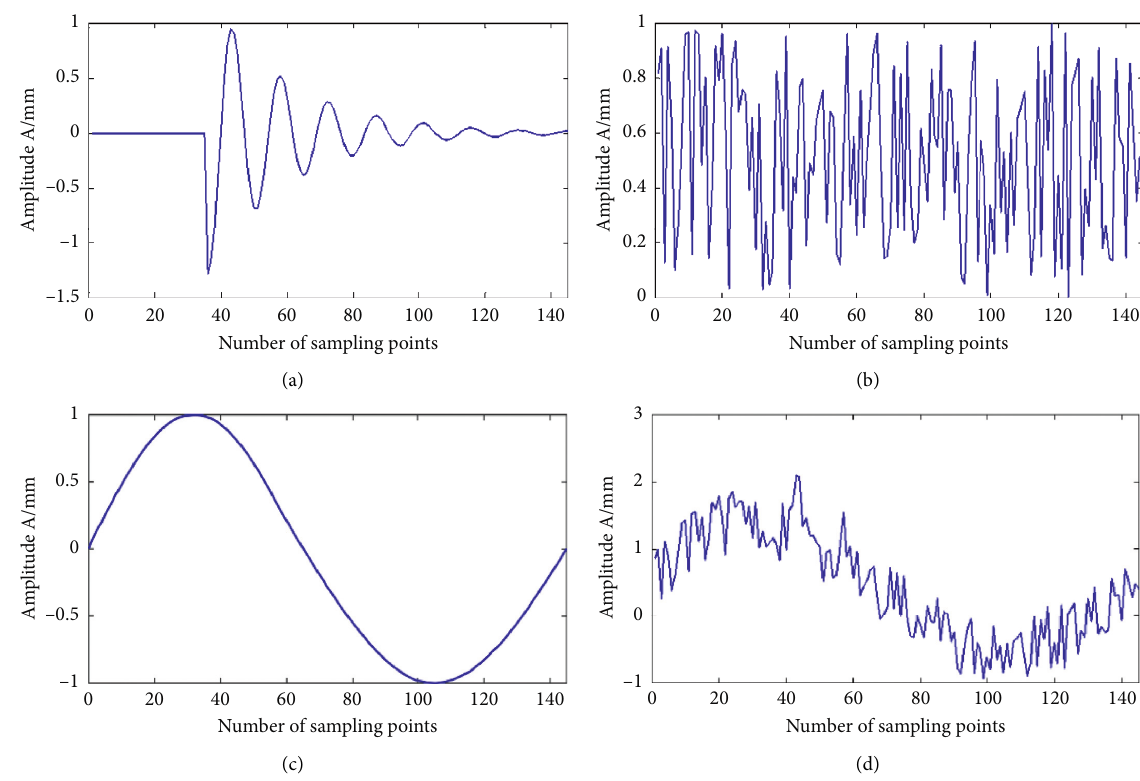
Figure 4: Simulation signal. (a) The simulated impact signal g ( t ) , (b) the white noise signal x ( t ) , (c) the power frequency signal f ( t ) , and (d) composite signal s ( t ) .